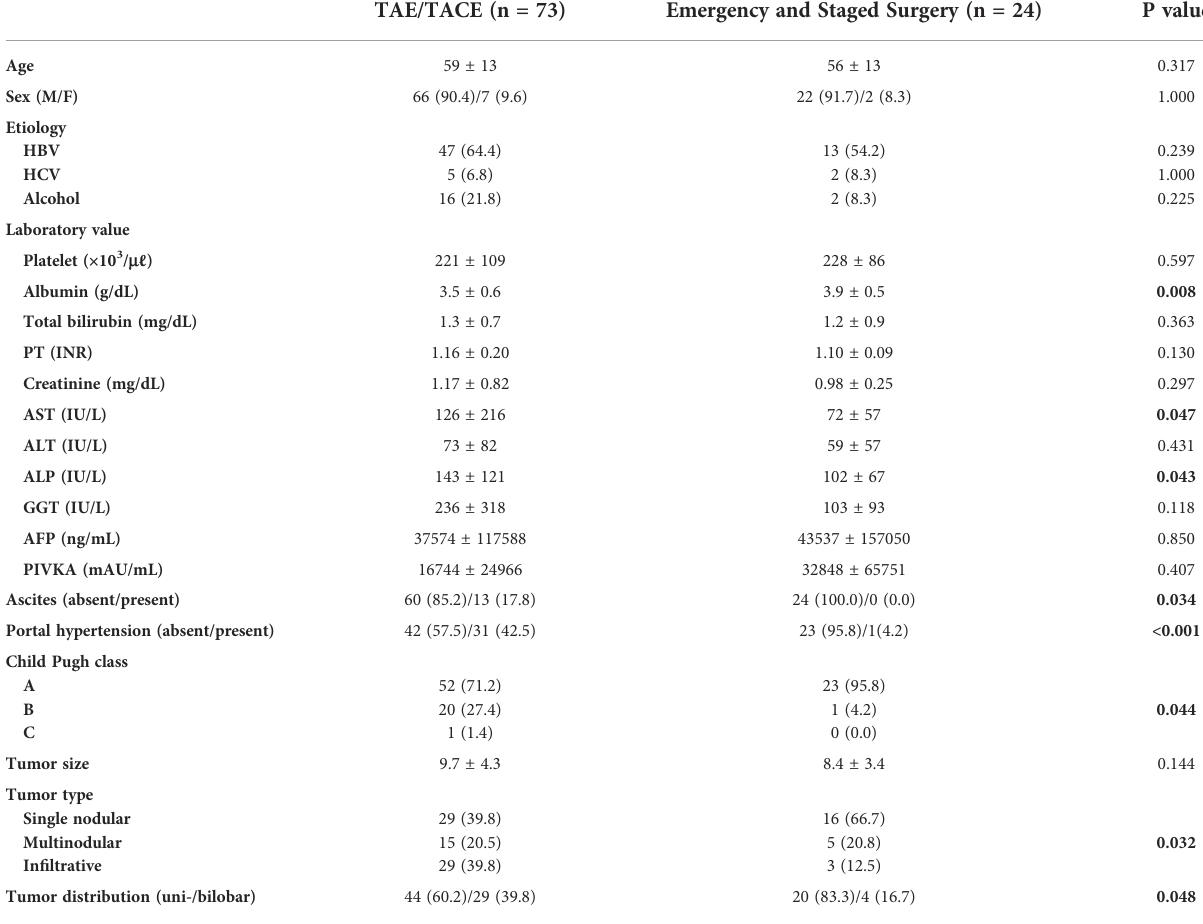
TABLE 2 Characteristics of the study sample undergoing transcatheter arterial embolization or surgery in the curative treatment group. TAE/TACE (n =